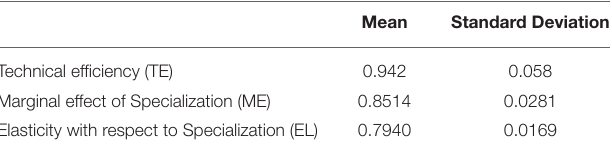
TABLE 4 | Distribution of technical efficiency and the marginal effect and elasticity of technical efficiency with respect to